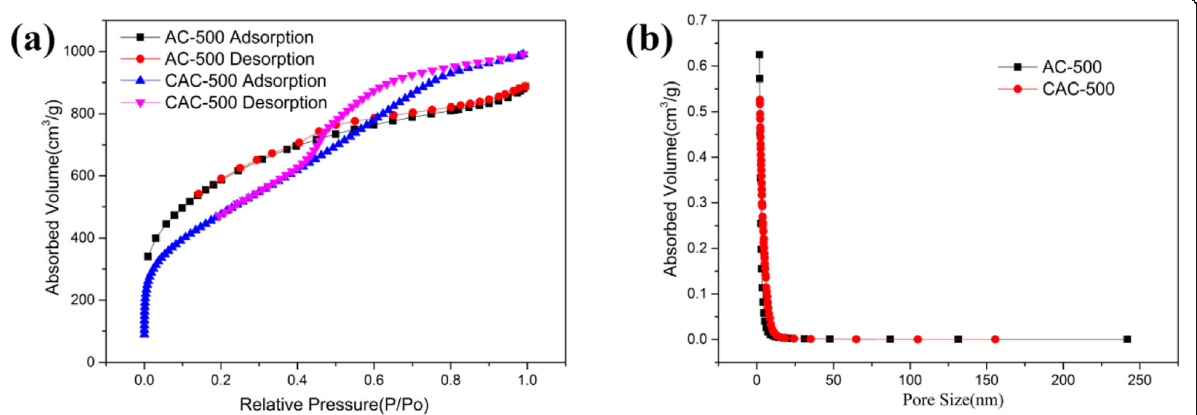
Fig. 5 a Isothermal adsorption-desorption curve of AC-500 and CAC-500. b Pore size distribution of AC-500 and